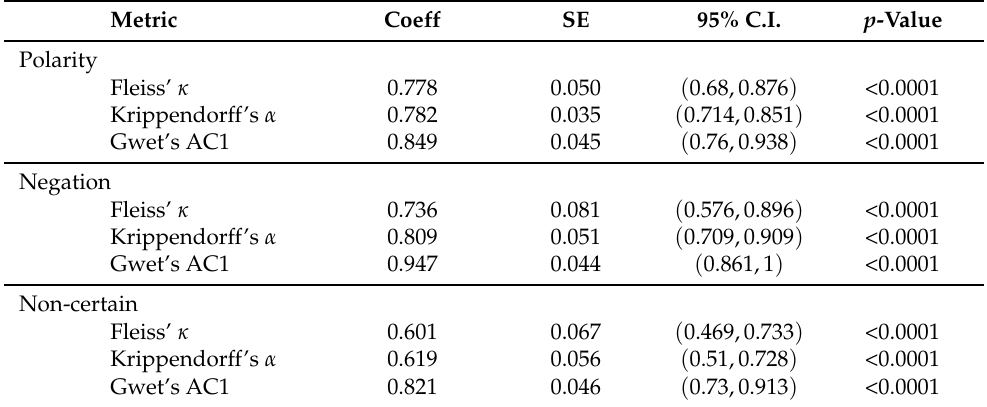
Table 2. Directly-annotated polar expression agreement scores on polarity, negation, and non- certain